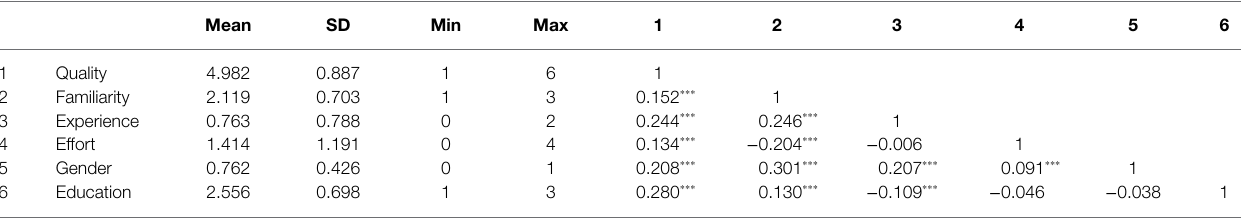
TABLE 1 | Means, standard deviations, and correlation coefficients of all study